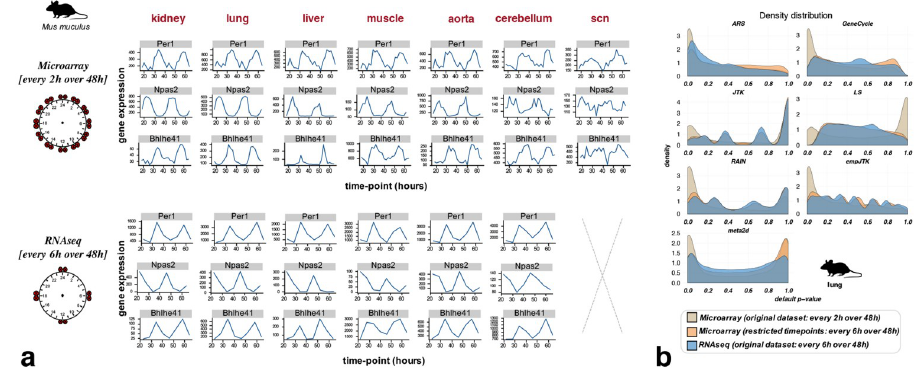
Fig 2. Fewer time points per cycle lead to a weaker detection of rhythmic patterns even if the transcriptome profiling quality is better. a) Bhlhe41, Npas2, and Per1 expression over time from data of the same mouse experiment [2] using two transcriptome profiling techniques: microarray vs RNAseq. The number of time-points with data is 24 for microarray and 8 for RNAseq. b) The restriction of microarray time-series to the same time-points as in the RNAseq series produces similar p -value distributions to those obtained with RNAseq. This supports a major role of the temporal resolution for method results, relative to a minor role for the difference between RNAseq and microarrays. Mouse image credit to Anthony Caravaggi (license CC BY-NC-SA 3.0).